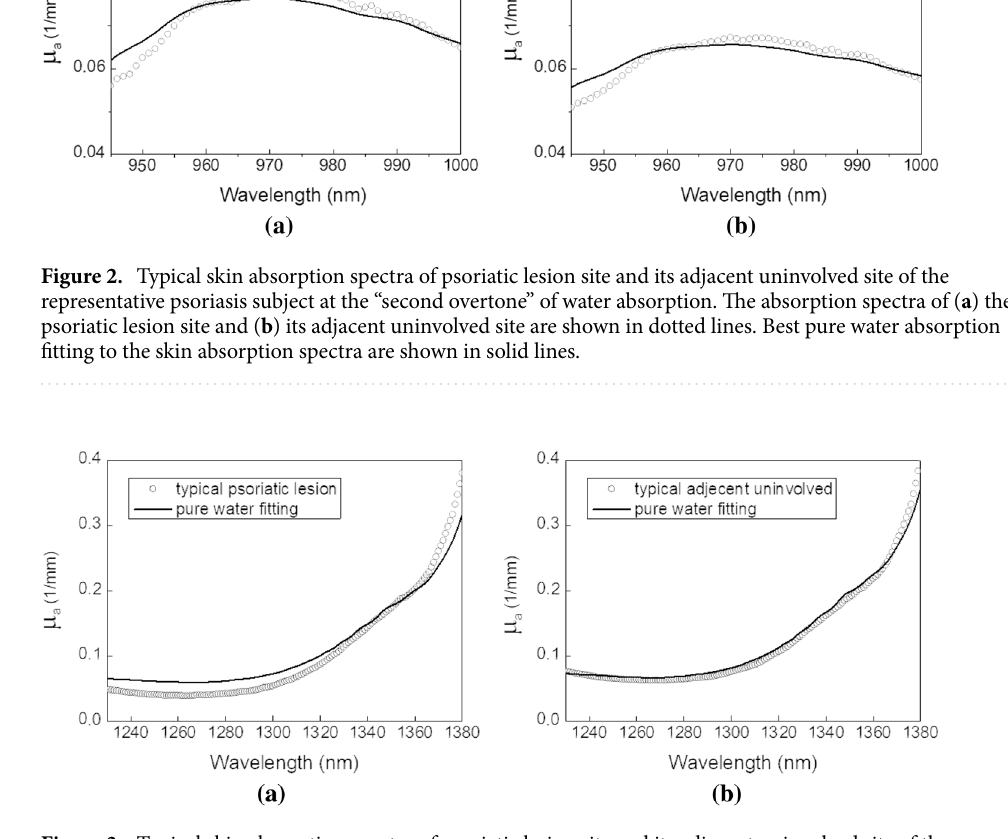
Figure 3. Typical skin absorption spectra of psoriatic lesion site and its adjacent uninvolved site of the representative psoriasis subject at the “first overtone” of water absorption. The absorption spectra of ( a ) the psoriatic lesion site and ( b ) its adjacent uninvolved site are shown in dotted lines. Best pure water absorption fitting to the skin absorption spectra are shown in solid